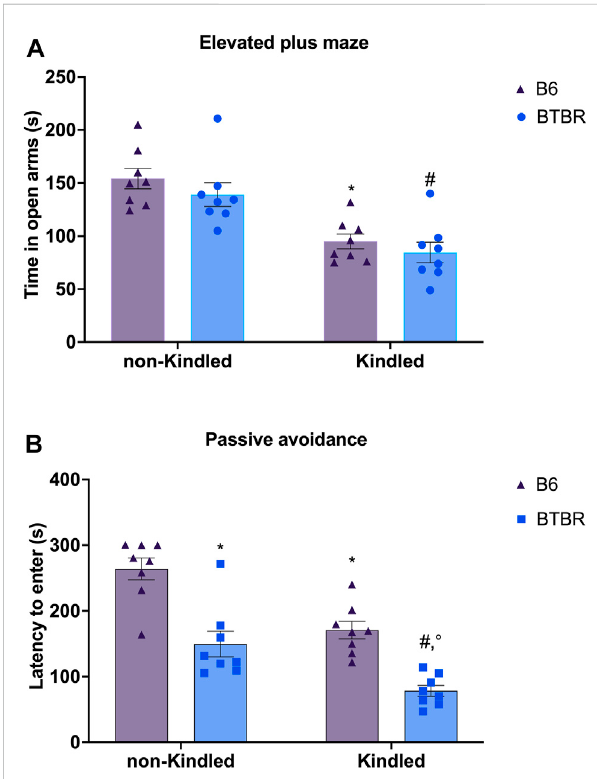
FIGURE 4 Elevated plus maze (EPM) and passive avoidance (PA) tests performed at the end of the PTZ-kindling procedure. (A) Bars indicate time spent in the open arm (s) in the EPM test. (B) Bars indicate the latency(s)toenterintothedarkchamberinthePA.*Indicates p < 0.05 vs. non-kindled B6 mice, # Indicates p < 0.05 vs.